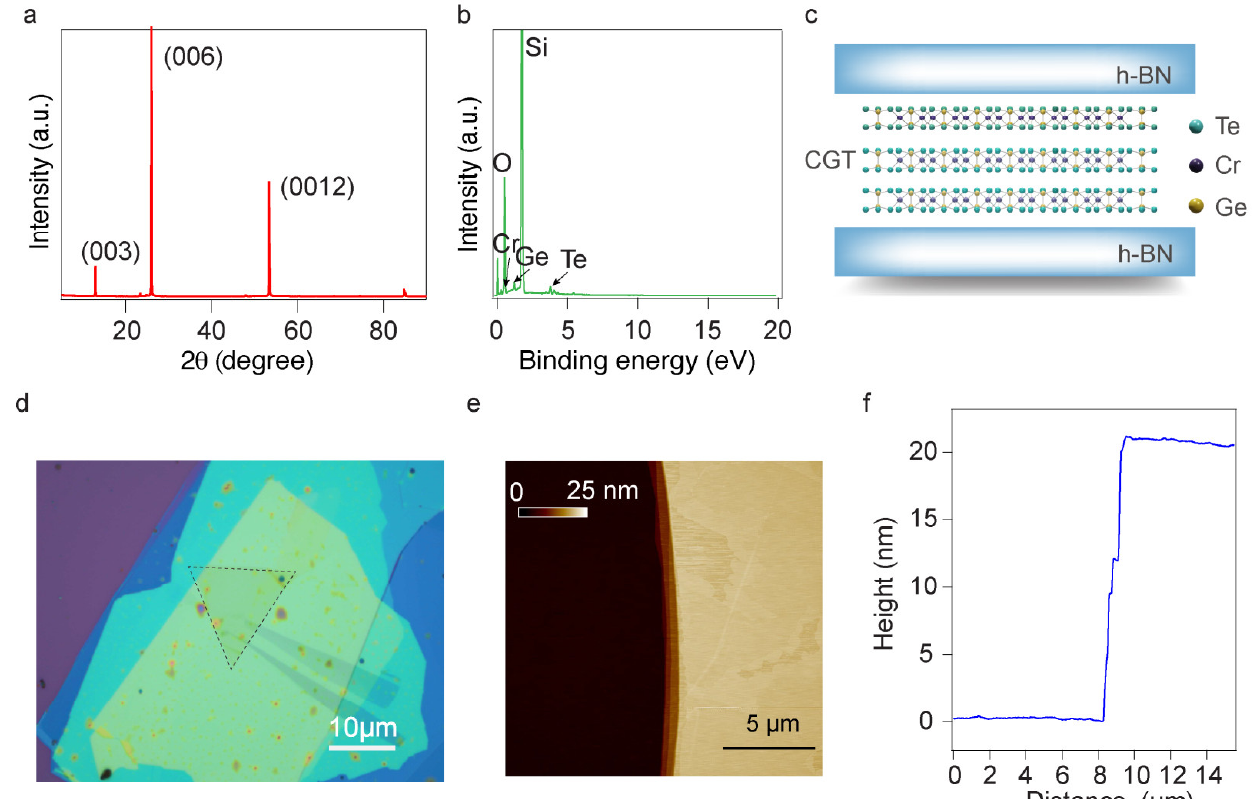
Figure 1. The results of XRD ( a ) and EDS ( b ) measurement, respectively, confirming the crystal structures and element ratios of bulk CGT. ( c ) Schematic diagram of h-BN encapsulated CGT heterostructure. ( d ) The optical photograph of a partially degraded CGT sample. CGT flake is sandwiched by top and bottom h-BN, with the edge of the CGT crystal indicated by the black dashed lines. Scale bar is 10 µ m. ( e ) AFM profiles of a typical h-BN used to compose the sandwiched CGT heterostructure. ( f ) The linecut of the morphology in ( e ) to determine the thickness of the h-BN.